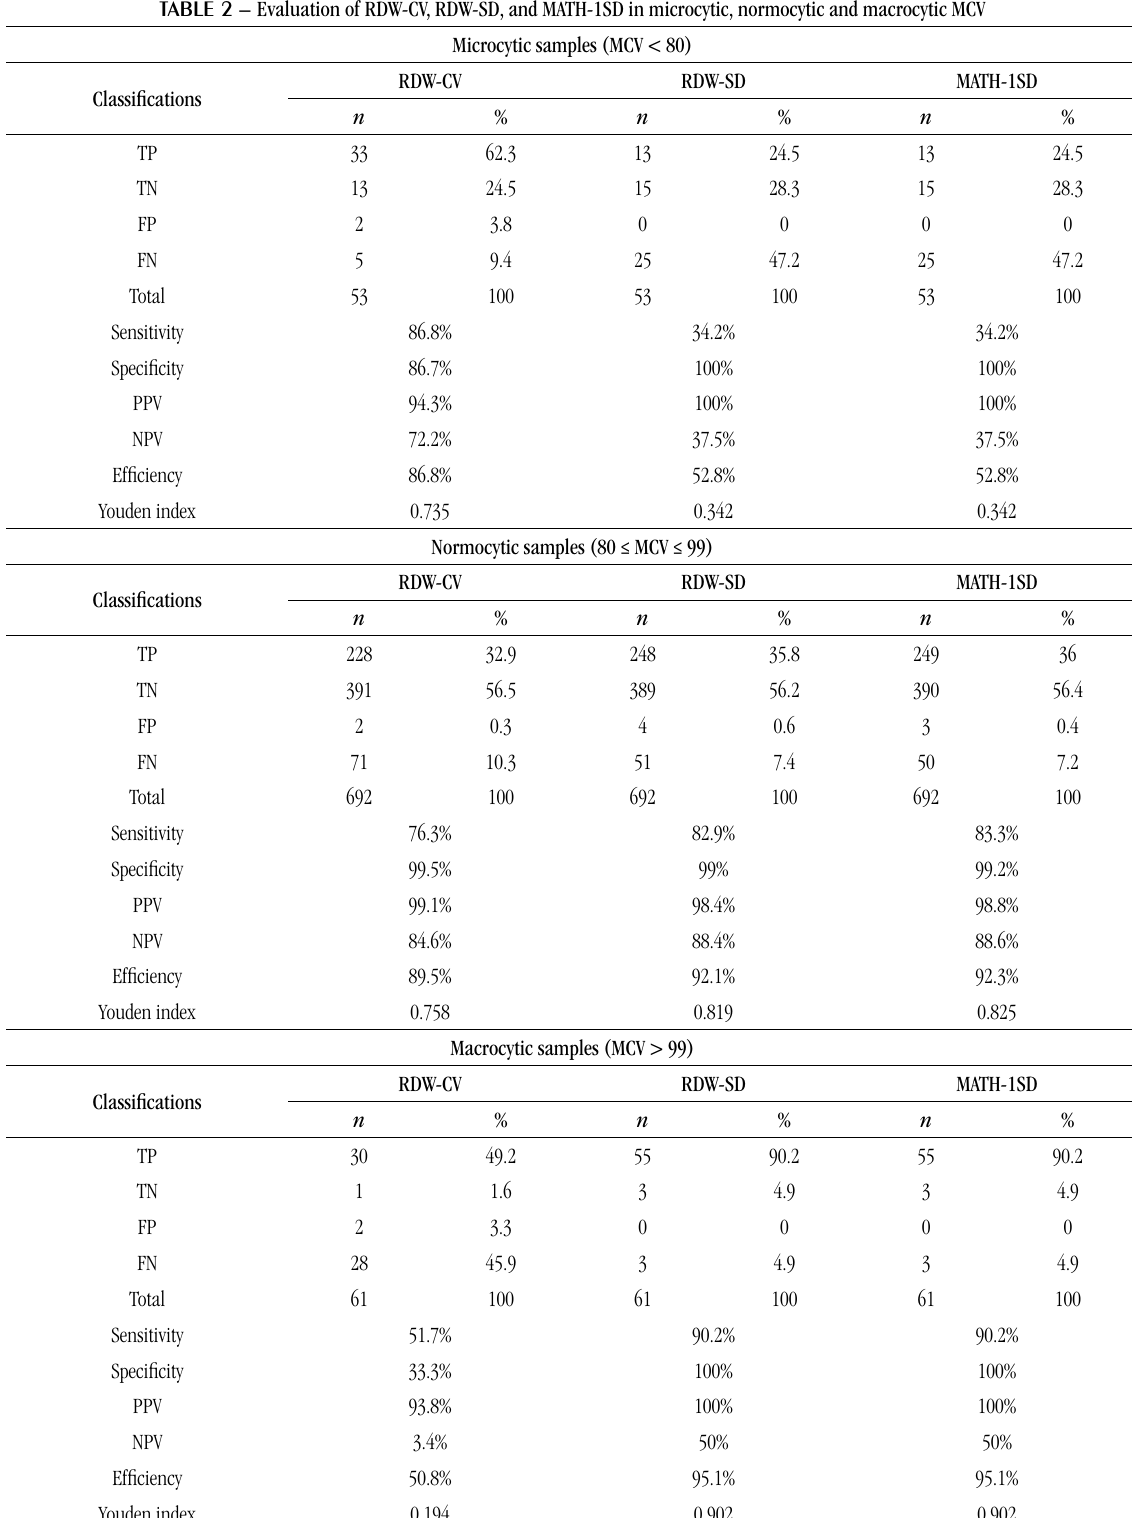
tABLE 2 – Evaluation of RDW-CV, RDW-SD, and MATH-1SD in microcytic, normocytic and macrocytic